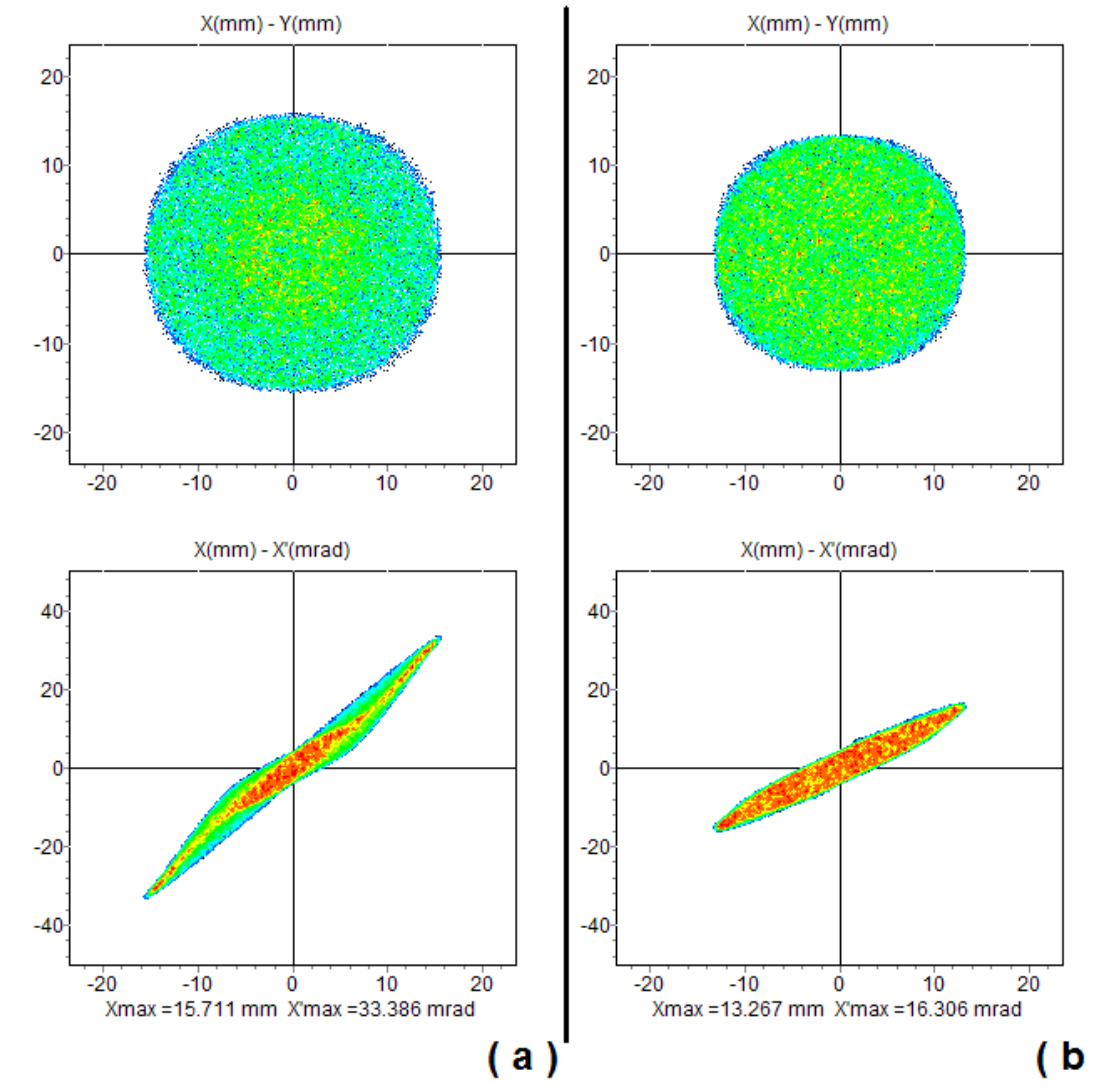
FIG. 14. (Color) The H (cid:2) beam at the drift exit (a) at 0 : 7 (cid:6) s and (b) at 2 (cid:6) s